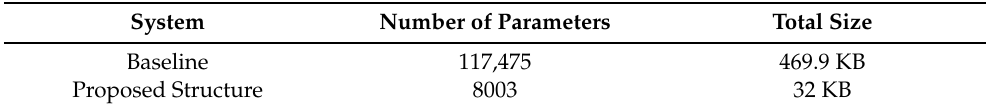
Table 3. Model sizes of the baseline network and the proposed architecture in KB when each parameter is a 32 bit floating